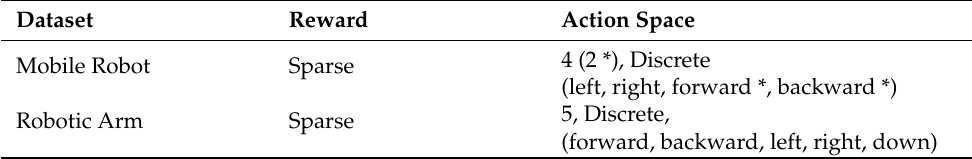
Table 2. The property descriptions of two simulation environments . Dataset Reward Mobile